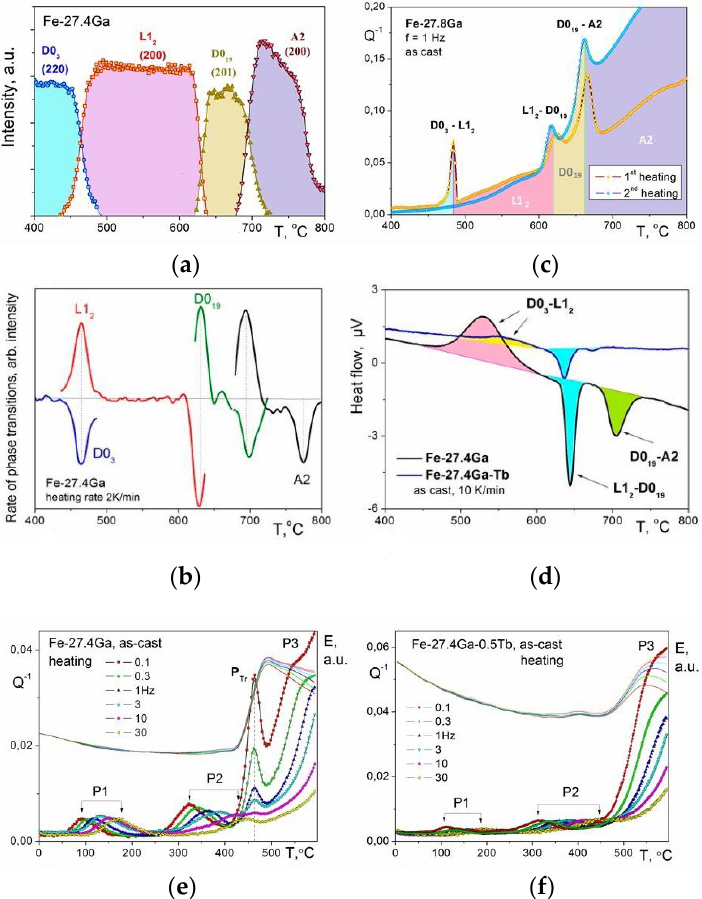
Figure 21. Fe–27Ga type alloys in as-cast state: temperature dependence of ( a ) selected reflections from neutron diffraction for phase identification, ( b ) rate of phase transitions according to neutron diffraction, ( c ) internal friction curves (torsion) with transient peaks due to phase transitions, and ( d ) heat flow (Fe–27Ga and Fe–27Ga–Tb). Heating rate in ( a , b ) equals 2 K/min, ( c )—1 K/min, ( d )—10 K/min. TDIF and TDEM curves (bending) at different frequencies from 0.1 to 30 Hz for continuous heating (1 K/min) for the parent Fe–27Ga ( e ) and Fe–27.4Ga–0.5Tb ( f ) in as-cast state [46].